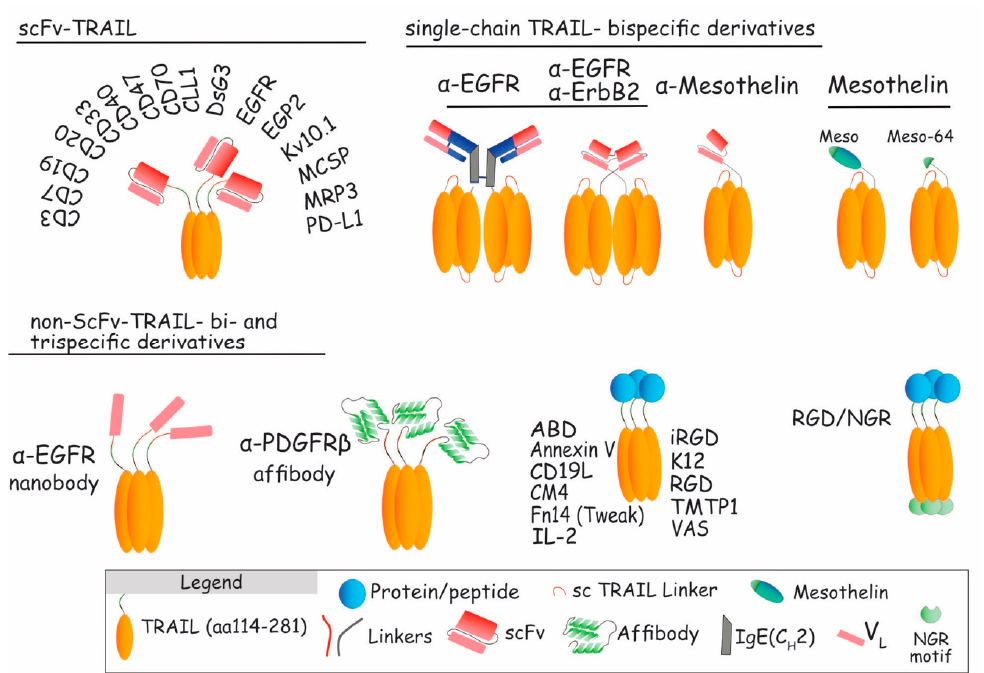
Figure 7. Schematic representation of scFv-TRAIL and non-scFv-TRAIL constructs. Upper left: